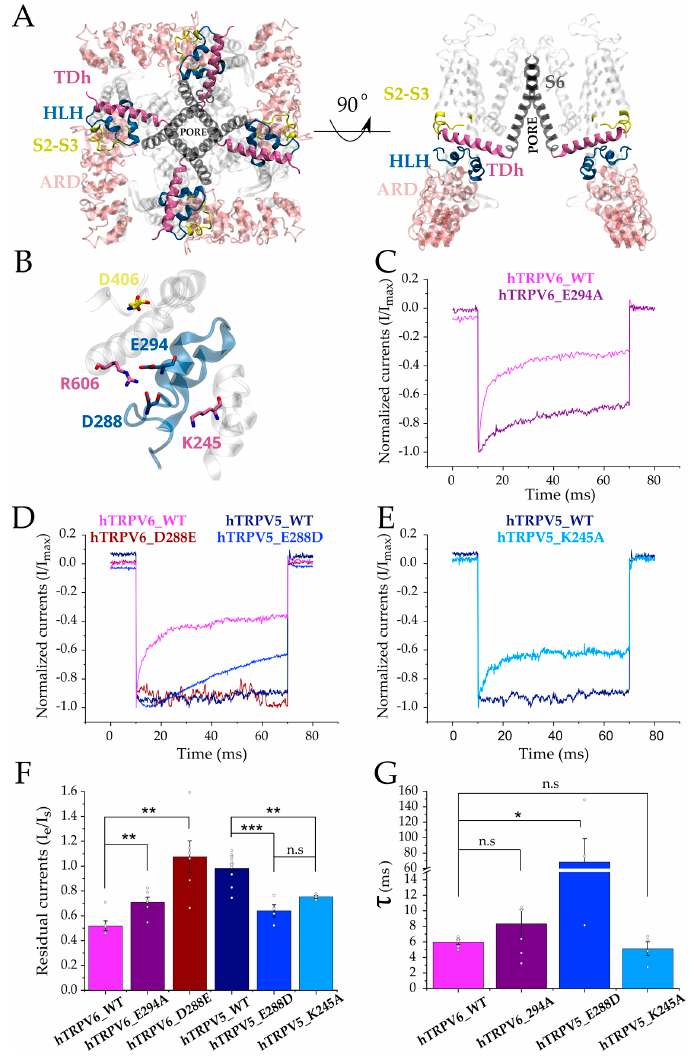
Figure 3. HLH interaction network modulates the inactivation kinetics of hTRPV5 and hTRPV6 ion channels. ( A ) Structure of the tetrameric hTRPV6 ion channel (PDB: 7S88). The structure shows the TDh (mauve) connecting the S6 segment (dark gray) with the HLH (blue) and S2-S3 linker (yellow) domains. ARD in close contact with the HLH is shown in pink. The right panel shows two subunits for easier visualization. ( B ) Representation of residues involved in the differential interdomain interactions of the HLH (in blue) within the inactivation motif of hTRPV5 and hTRPV6 (numbers according to hTRPV6). ( C ) Normalized whole-cell current traces recorded from transiently transfected HEK-293T cells expressing wild-type (WT) hTRPV6 and mutant hTRPV6–E294A chan- nels. ( D ) Normalized whole-cell current traces recorded from transiently transfected HEK-293T cells expressing WT hTRPV5, hTRPV6, and mutant hTRPV6–D288E and hTRPV5–E288D channels. ( E ) Normalized whole-cell current traces recorded from transiently transfected HEK-293T cells ex- pressing WT hTRPV5 and mutant hTRPV5–K245A channels. ( F ) Pooled data comparing the residual currents (defined as the ratio between the currents at the end (Ie) versus the beginning (Is) of the voltage pulse). ( G ) Pooled data for the time constants of inactivation for clones showing a fast current decay. All current traces were recorded with 2mM extracellular Ca 2+ and elicited in response to a 60 ms pulse at − 160 mV from Vh = 0mV (Panels C , D , E ). Bars represent mean value; errors represent S.E.M, and white dots represent values for each experiment (Panels F , G ). *** represents p = 0.001; ** p = 0.01; * p = 0.05; n.s.= not statistically